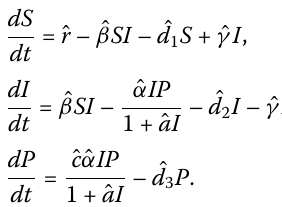
Natural death rate of